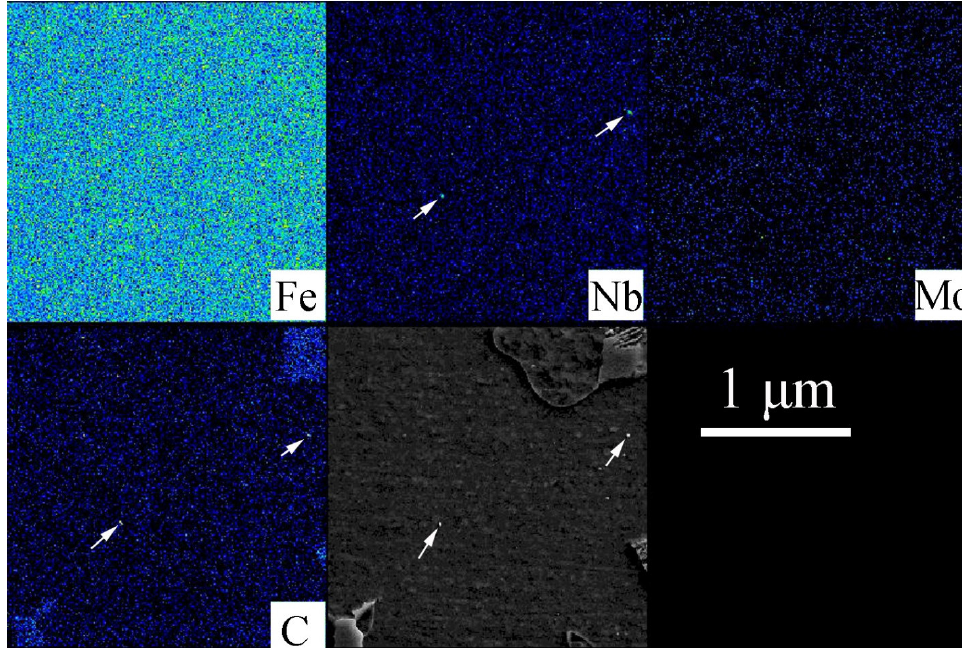
Figure 7. Element distribution in N2-HR steel.